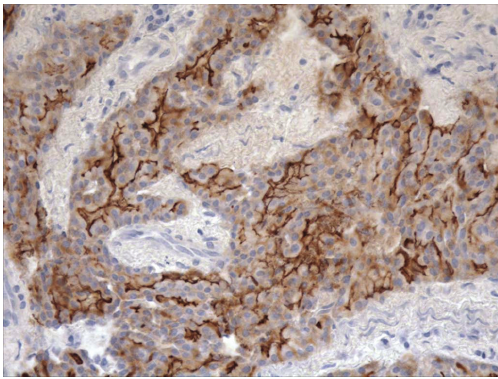
Figure 4: Immunohistochemistry of nasal mass using mouse monoclonal antibody against JSRV envelope protein. Note the positive apical